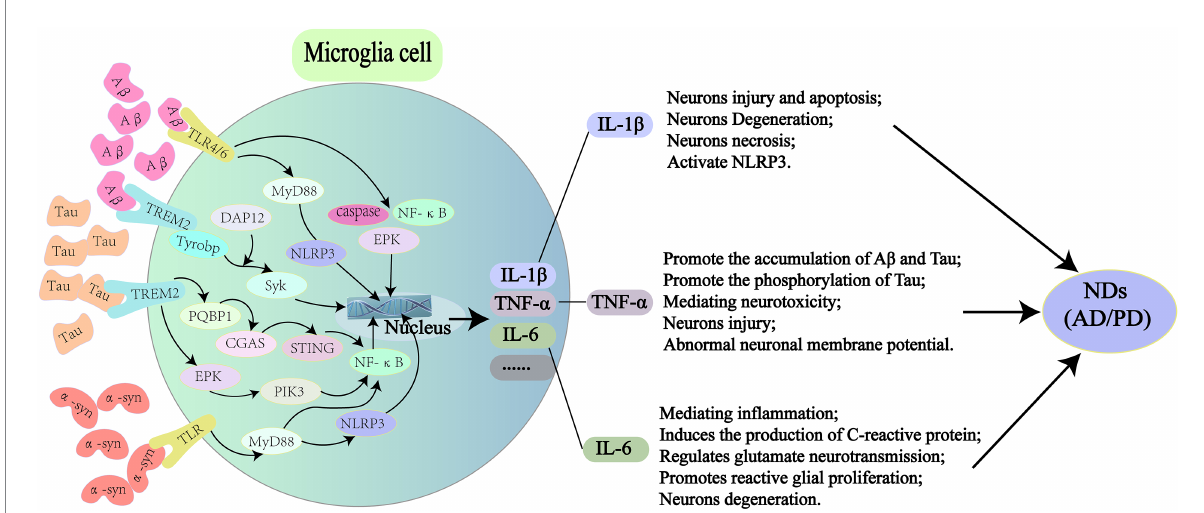
FIGURE 2 Pathogenic proteins activate signal transduction pathways in microglia leading to NDs. In AD, A β can bind to TLR4/6 on microglia and induce the release of inflammatory factors (IL-1 β , TNF- α , and IL-6) through the downstream MyD88/NLRP3 and NF- κ B signaling pathways. It also activates TREM2 on microglia, causing DAP12 to enhance Syk and induce a cascade of protein tyrosine phosphorylation, which leads to apoptosis and myelin damage through immune pathways. For Tau protein, it can activate microglia through PQBP1/CGAS/STING pathway, and 40% NF- κ B can amplify inflammatory response in this process, leading to a series of nerve damage. The rest is supplemented by TREM2/ERK/PIK3. In PD, α -syn can stimulate microglia to secrete proinflammatory cytokines, such as ROS, TNF- α , IL-1 β , COX2, and iNOS through TLR/MyD88/NLRP3 pathway. It also binds to TLR2 to induce nuclear translocation of NF- κ B, which triggers the production of NLRP3, pro-IL-1 β and pro-IL-18, and ultimately IL-1 β secretion. TLR, toll-like receptors; MyD88, myeloid differentiation factor 88; NLRP3, NOD-like receptor thermal protein domain associated protein 3; NF- κ B, nuclear factor kappa-B; TREM2, triggering receptor expressed on myeloid cells 2; DAP12, TYRO protein tyrosine kinase binding protein; PQBP1, polyglutamine binding protein-1; CGAS, cyclic GMP-AMP synthase; STING, interferon gene stimulation protein; ERK,